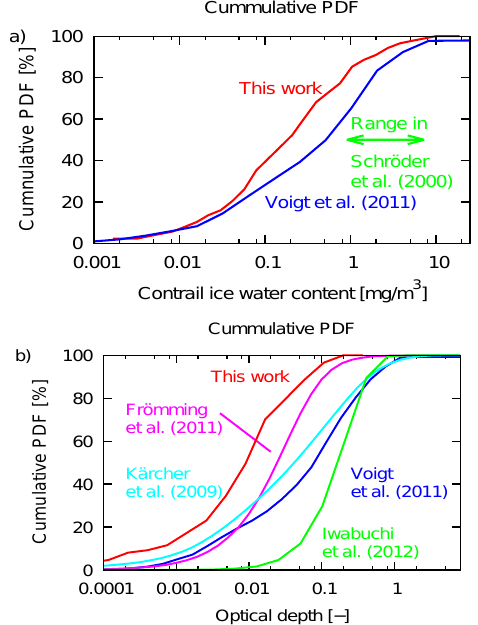
Fig. 10. Intercomparison of observed and simulated distributions of contrail properties. Estimated cumulative probability density func- tions of contrail ice water content [mg m − 3 ] (a) and (b) visible optical